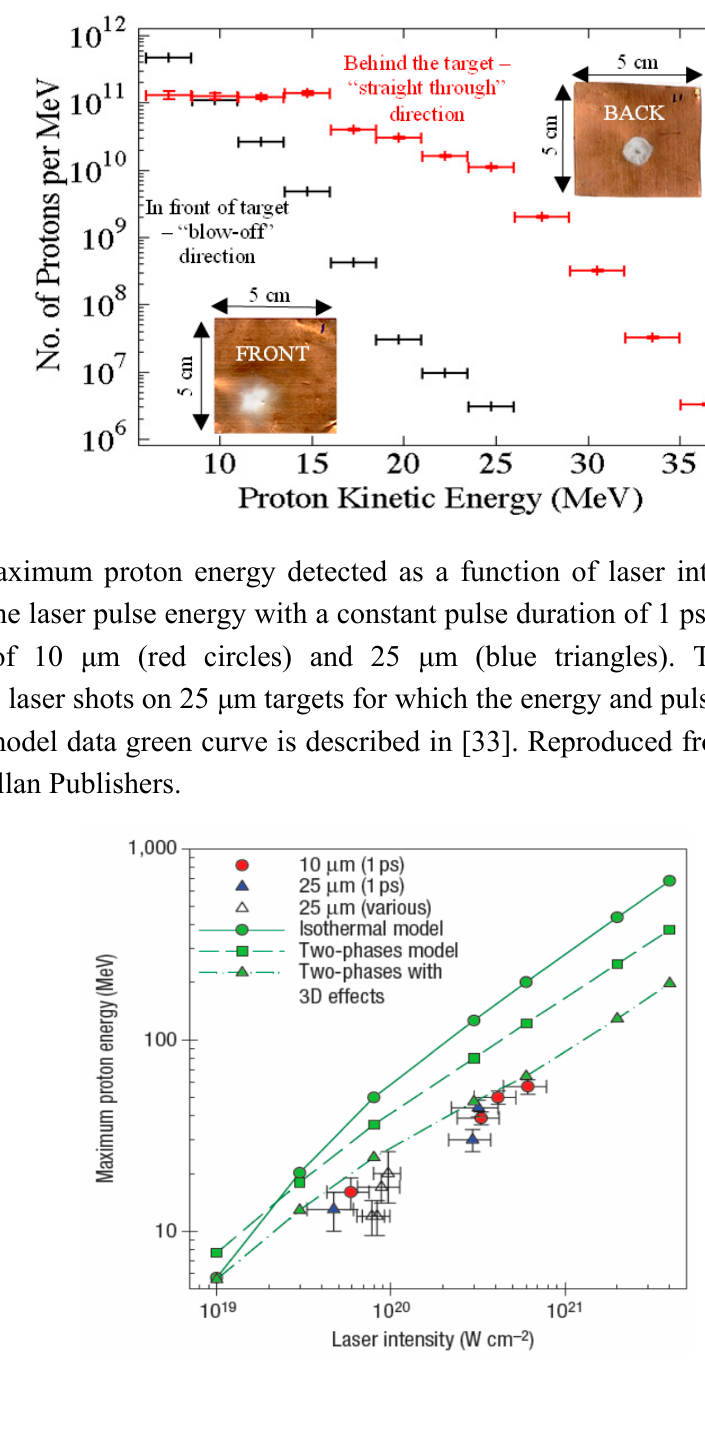
Figure 3. Proton energy spectrum from copper activation stacks in front of and behind the target. Inserts show the first copper piece in each stack containing proton spatial information [32]. It should be pointed out that, if radioactivity in activation stacks is used as a proton diagnostic then, to be an unambiguous diagnostic for protons, the nuclear reaction must be identified, e.g., using Cu activation stacks the 63 Cu(p,n) 62 Cu with a 10 min half-life was measured. A number of authors have used just a general radioactive measurement as a diagnostic which unfortunately also includes neutron and photon activated sources of radioactivity. Reproduced from [32]. Copyright 2001, Elsevier.